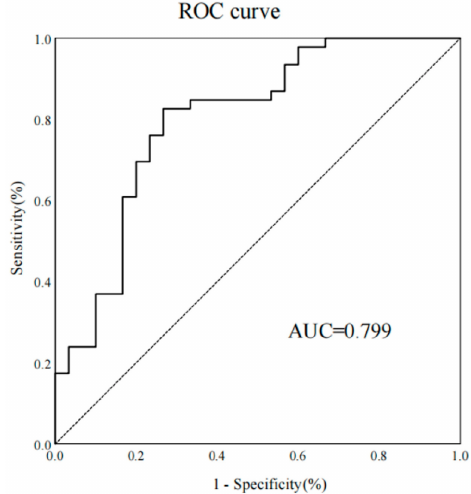
Figure 4. The receiver operating characteristic (ROC) curve was measured using the validation set. AUC, area under the